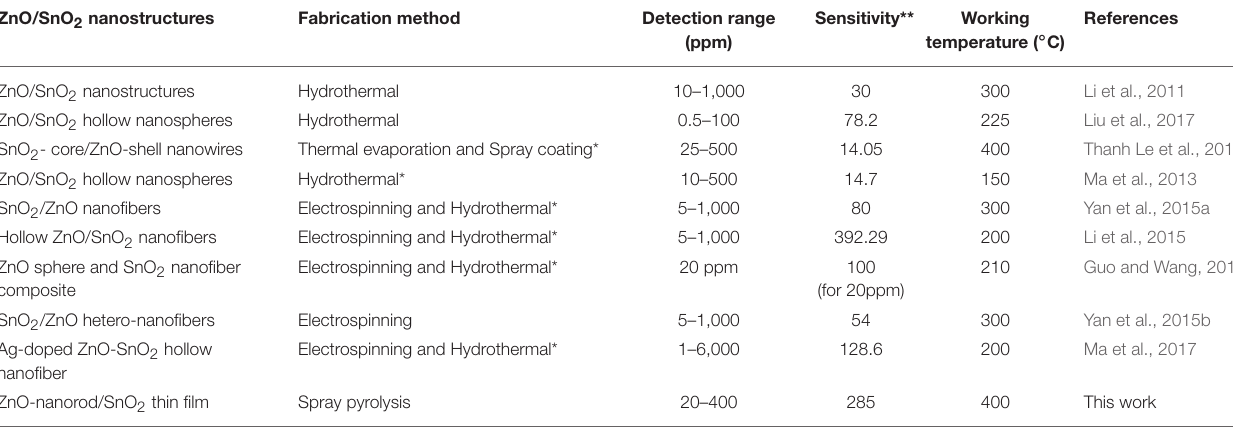
TABLE 2 | Brief summary of ZnO/SnO 2 nanostructures gas sensor upon exposure to 100 ppm